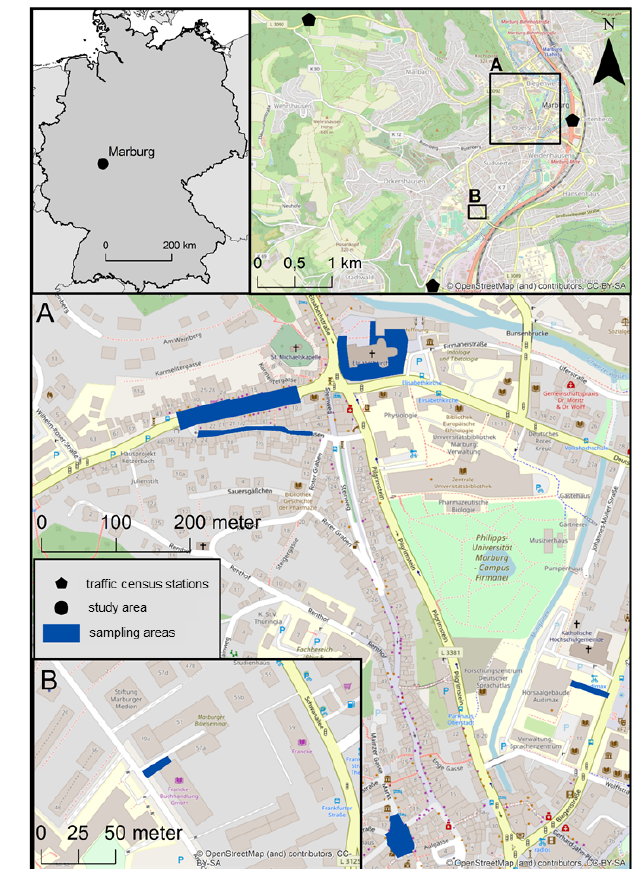
Figure 1. Study area map composition. (a) Inner city area of Mar- burg. (b) Sampling site Schwanhof (FV) in the southwestern area of the inner city. Data source: © OpenStreetMap contributors 2020 and Hessian Administration for Soil Management and